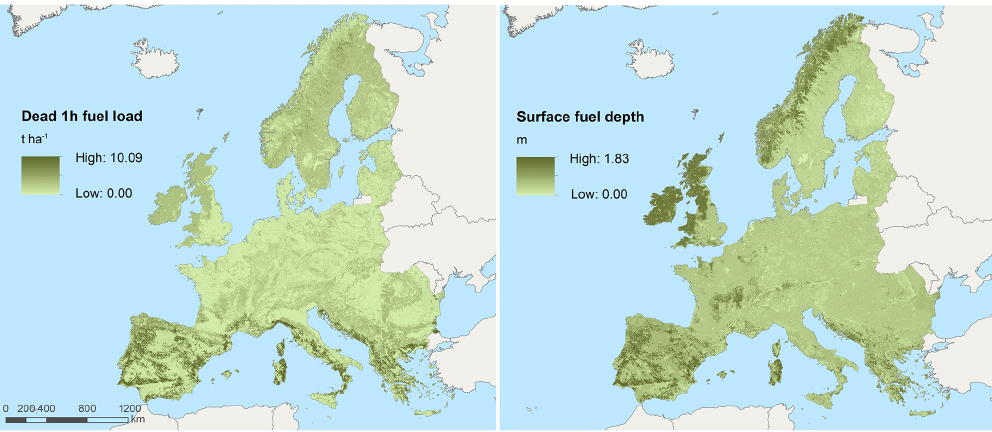
Figure 7. Surface dead 1h fuel load and fuel bed depth over Europe obtained from the crosswalk from the FirEUrisk fuel types to the FBFM models. Note that surface fuel bed depth for the forest fuels refers to the understorey and not the